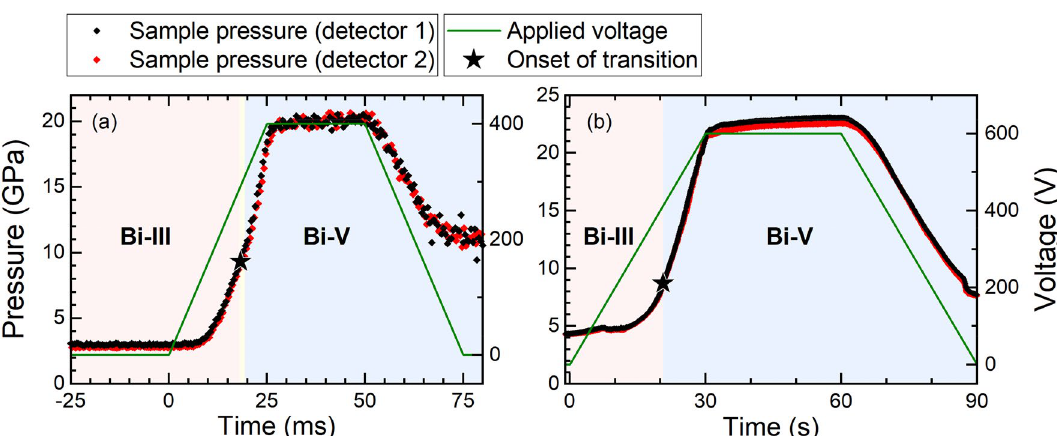
Figure 2. Time-dependent pressure profile for ( a ) fast and ( b ) slow compression cycles on Bi foil using the dDAC, and the corresponding voltage applied to the piezo actuator. The pressure was estimated from the Au pressure marker, as described in the text. The stars indicate the onset of the Bi-III/Bi-V transition. The average compression rates during the ramp are ( a ) 680 and ( b ) 0.56 GPa/s and the instantaneous compression rates at the transition are ( a ) 785 and ( b ) 1.13